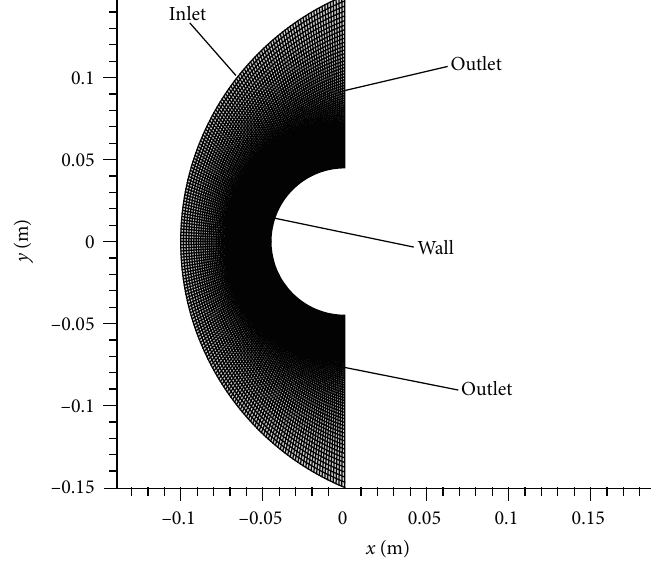
Figure 5: The computational